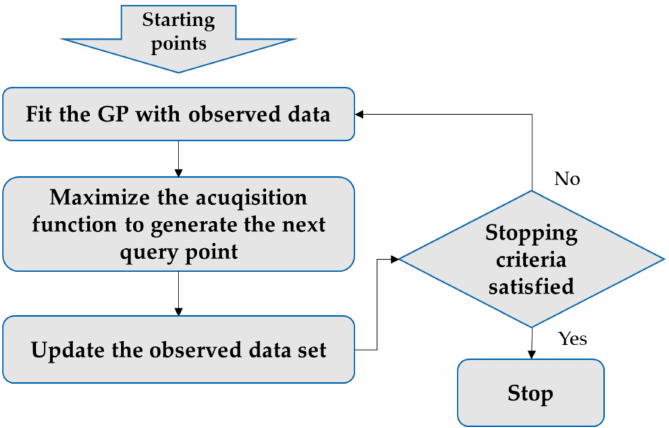
Figure 1. Illustration of the Bayesian optimization (BO) algorithm.